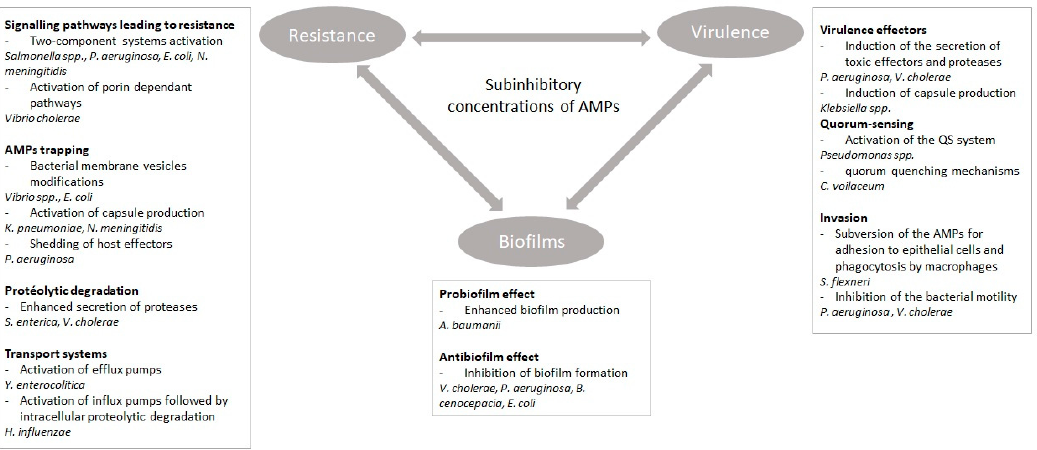
Figure 1. Impact of subinhibitory concentrations of antimicrobial peptides on resistance, virulence, and biofilm formation in Gram-negative bacteria. The double arrows illustrate the connections between virulence, resistance, and biofilm formation. Examples of Gram-negative bacteria responding to subinhibitory concentrations of antimicrobial peptides (AMPs) are provided in each section.